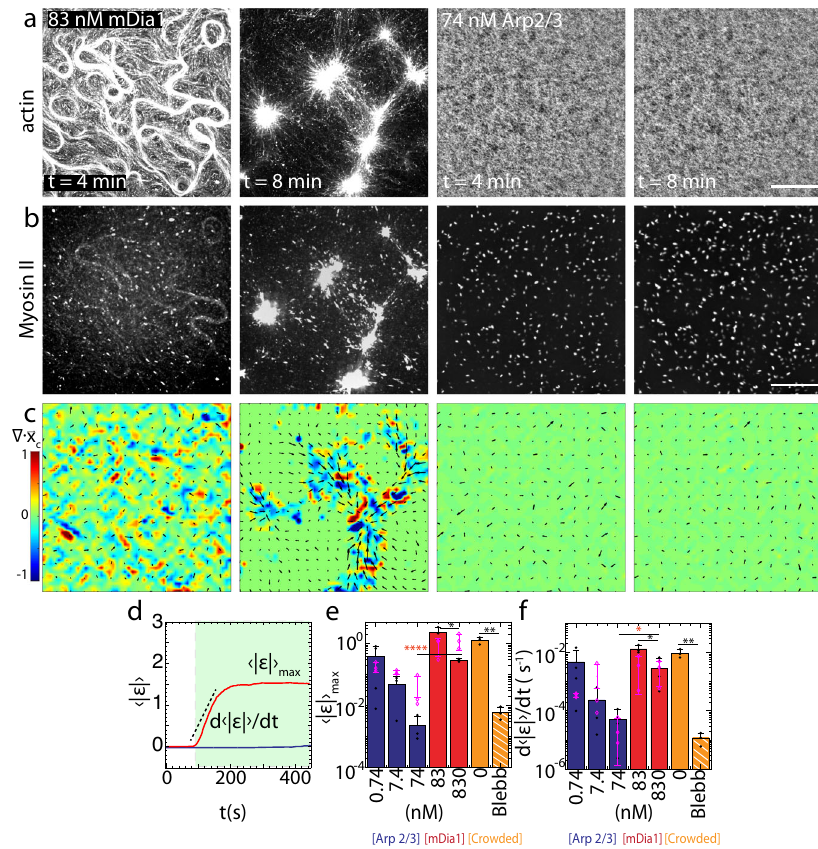
Fig. 2 | Contractility is attenuated in branched F-actin networks. a Fluorescent F-actin over time. t is time after the addition of myosin dimers. b Fluorescent myosin II on the networks in a . c Divergence of actin displacements (strain) (col- ormap) and the local actin velocity fi eld (black arrows). d Absolute valued mean strain ( ε h i ), over time. The strain rate (d ε h i = d t ) and maximum mean strain ( ε h i max ) are indicated. Green shaded region indicates the regime of analysis. e ∣ ε ∣ h i max for differentnucleatorconcentrations.Blue:Arp2/3,Red:formin,orange:nonucleator (crowded network), and orange with white stripes: no nucleator +Blebbistatin. (* p <0.05, ** p <0.01, and *** p <0.001. p (74nM Arp & 830nM mDia1)= 0.000081, p (83nM mDia1 & 830nM mDia1) = 0.029, p (no nucleator & no nucleator +blebb)=